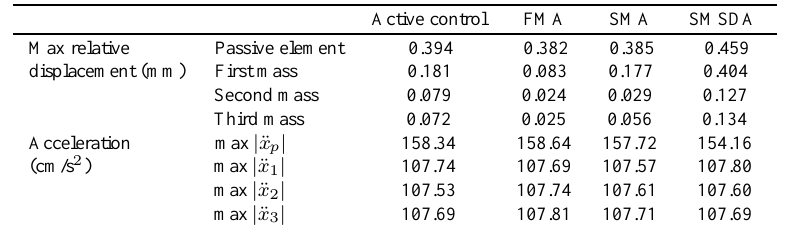
Table 3 Configuration 1-performance resulting from the use of the FMA, SMA and SMSDA approaches